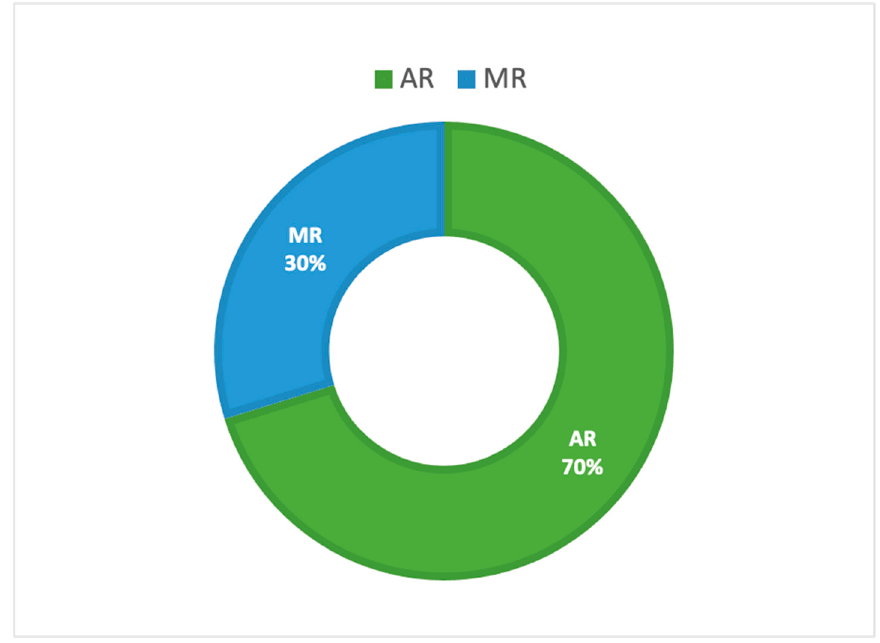
Figure 6. Reviewed publications related to HoloLens 2 research by types of visualization technologies.